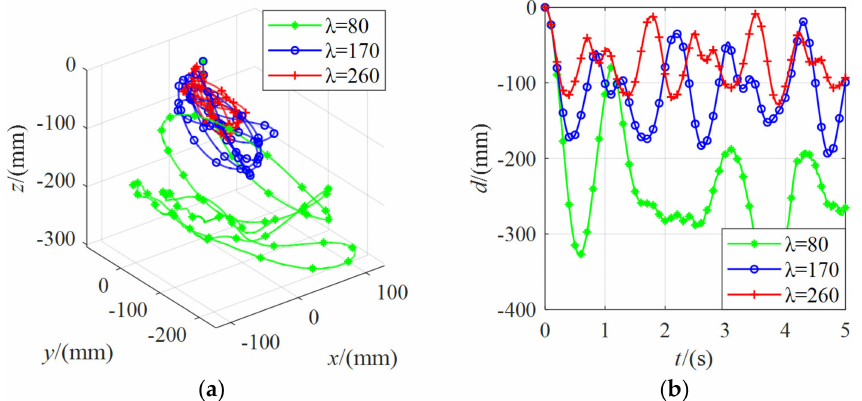
Figure 17. The position change of the moving platform under the external force of 10 N with different stiffnesses: ( a ) the coordinate curve of the moving platform center point in spatial coordinate system O-xyz ; ( b ) the variation curve of the linear distance between the center point of the moving platform and the initial